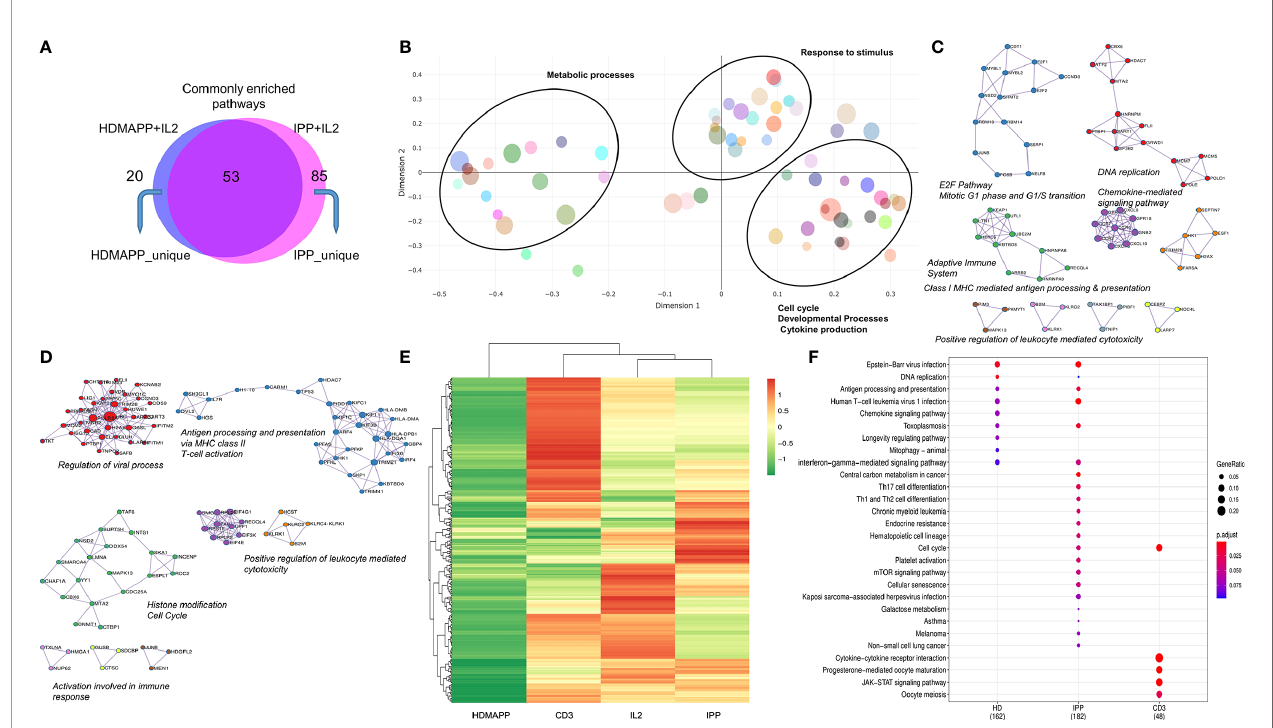
FIGURE 3 | Distinct transcriptional pathways are activated via each phosphoantigen. (A) Intersection of signi fi cant GO terms enriched for HDMAPP and IPP treatments. (B) A clustering-based semantic similarity mapping of most signi fi cant GO terms, showing how various pathways activated in HDMAPP treatment are distanced in a multidimensional scale. (C, D) Protein – protein interaction map for genes differentially enriched upon HDMAPP + IL2 and IPP + IL2 treatments over IL2, respectively. Most enriched corresponding processes are labeled. The maps were generated using Cytoscape with BioGrid, InWeb_IM, and OmniPath databases. (E) Clustered heatmap of most differentially regulated genes with each mentioned stimulation (also see Supplementary Figure S3 ). (F) KEGG pathway comparison was done for HDMAPP, IPP, and anti-CD3 stimulations. The dots indicate both signi fi cant enrichment and p-value for the mentioned pathway. n = 3 was used for each